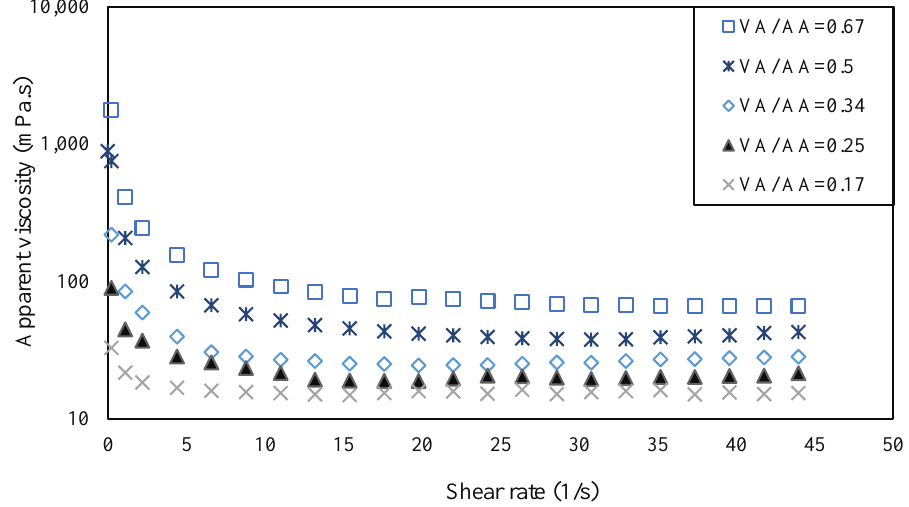
Figure 4. Variations in apparent viscosity with shear rate for different geopolymeric pastes (different VA/AA).